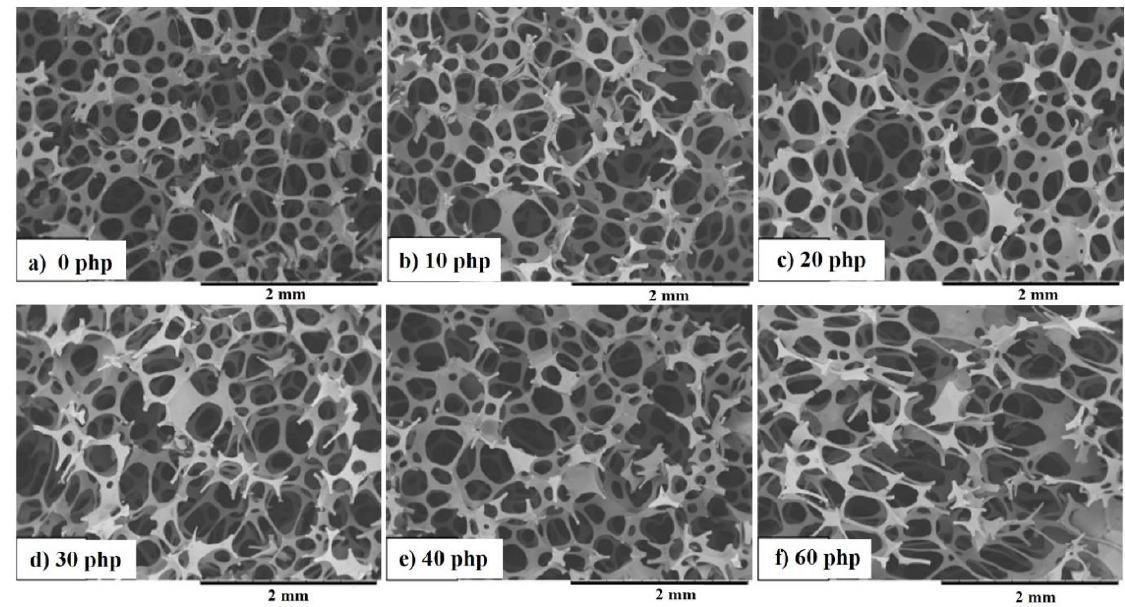
Figure 7. SEM images of VEPUR foam ( a ) and its composites with BCP: ( b ) 10 php, ( c ) 20 php, ( d ) 30 php, ( e ) 40 php, ( f ) 60 php.